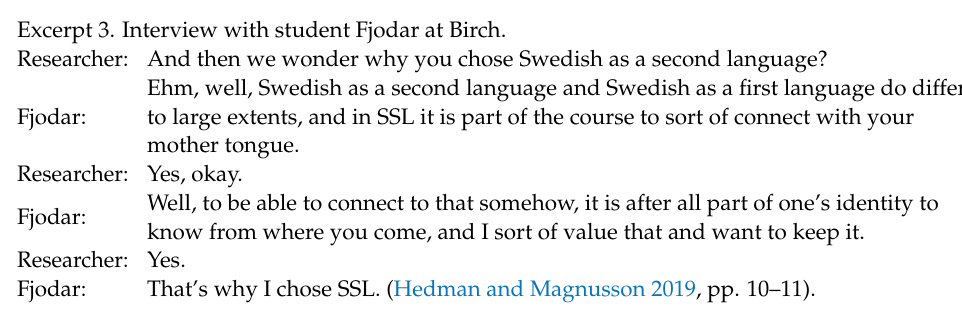
Figure 1. Degrees of focus on students’ multilingual